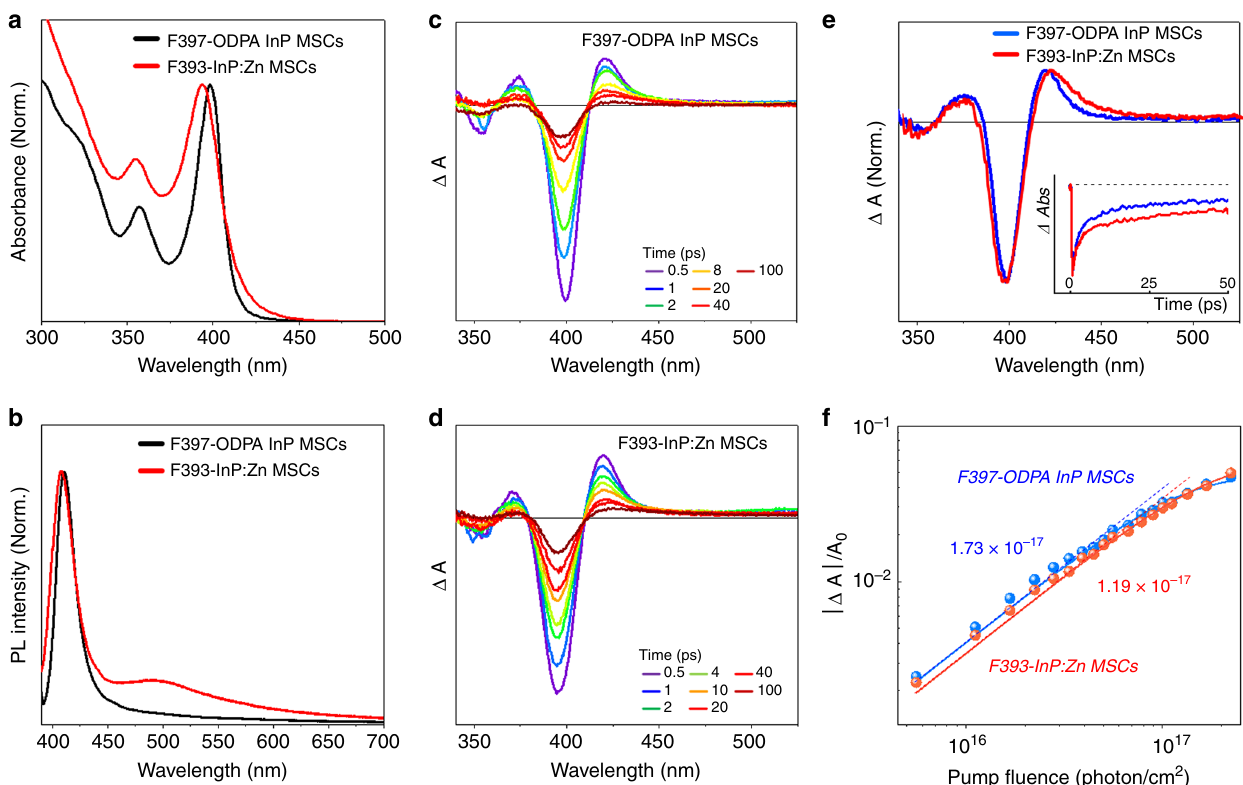
Fig. 9 Optical characterizations of F393-InP:Zn MSCs and F397-InP MSCs. Steady-state absorption and PL spectra of a F397-ODPA InP MSCs and b F393-InP:Zn MSCs. TA spectra of c F397-ODPA InP MSCs and d F393-InP:Zn MSCs. e Normalized TA spectra at 2 ps of F397-ODPA InP MSCs and F393-InP:Zn MSCs. (Inset: normalized TA decay pro fi le of F397-ODPA InP MSCs at 397 and of and F393-InP:Zn MSCs at 393 nm.) f Plot for normalized LEET bleach signals for F397-ODPA InP MSCs and F393-InP:Zn MSCs with the estimated absorption cross-section values σ abs (cm − 1